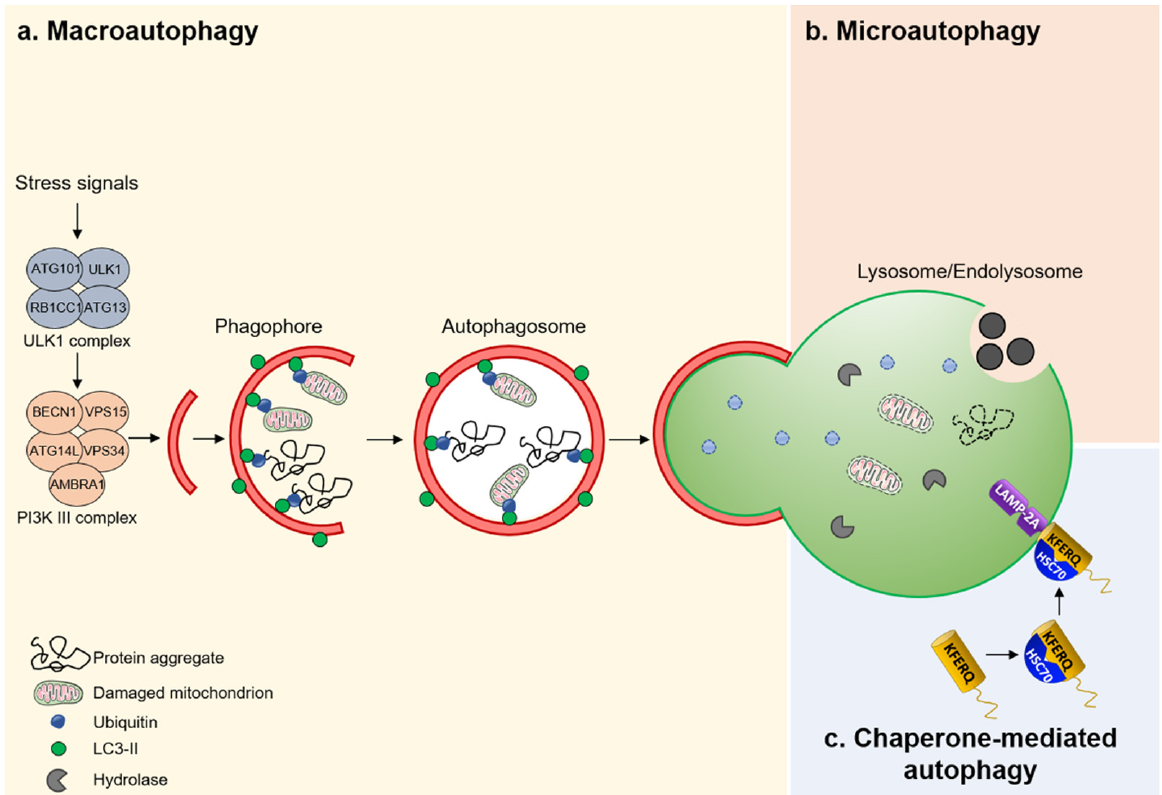
Figure 2. Different mechanisms of autophagy. ( a ) Macroautophagy is a nonselective bulk process that removes protein aggregates and/or damaged mitochondria. ( b ) Microautophagy captures cy- toplasmic constituents through direct invagination of endolysosome membranes. Resulting vesicles are subsequently released into the lumen of the endolysosome for degradation. ( c ) CMA identifies proteins containing a KFERQ pentapeptide-related motif by a chaperone complex HSC70 that trans- ports them into the lumen of the endolysosome through a receptor/translocon containing LAMP2A.